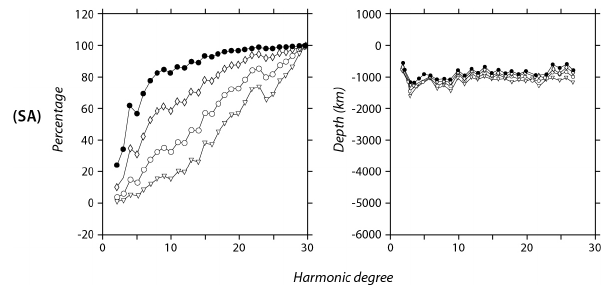
Figure 6. Percentage contribution curve (CCC) and estimated equivalent point-mass depths for the South American (SA) GEM-t2 geoid high. Depths are estimated from the percentage CCC using spline function coefficients for each degree. Spline functions are from model sets of two and three balanced point masses at depths of 100, 500, 1000, 2900, and